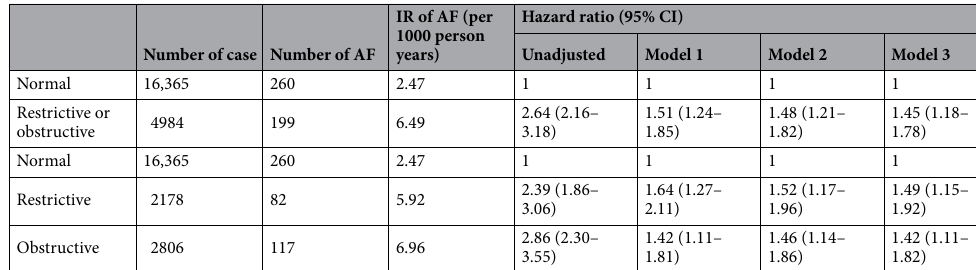
Table 4. Incidence rate and hazard ratios for the risk of atrial fibrillation according to restrictive or obstructive lung function impairment. Model 1: Adjust by age, sex. Model 2: Adjust by age, sex, body mass index, household income, education, alcohol consumption, smoking, diabetes mellitus, hypertension, dyslipidemia. Model 3: Adjust by age, sex, body mass index, household income, education, alcohol consumption, smoking, diabetes mellitus, hypertension, dyslipidemia, white blood cell, estimated glomerular filtration rate, prior stroke, prior ischemic heart disease, asthma. AF, atrial fibrillation; IR, incidence rate (events/1000 person years); CI, confidence